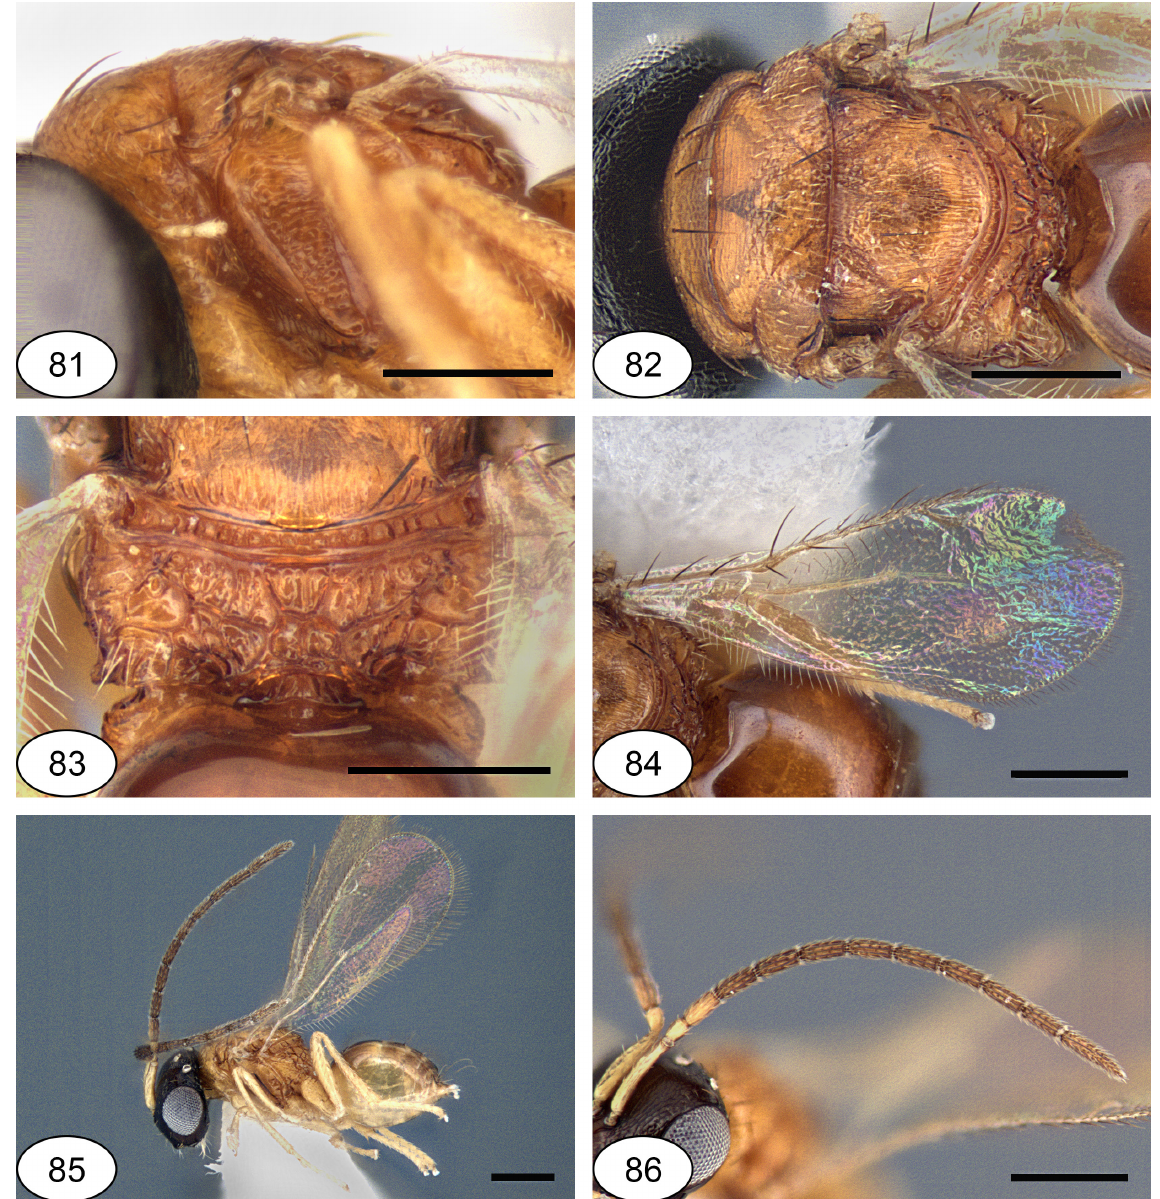
Figs 81–86. Netomocera gloriosa sp. nov. 81 . Holotype, ♀, mesosoma, lateral view. 82 . Holotype, ♀, mesosoma, dorsal view. 83 . Holotype, ♀, propodeum, dorsal view. 84 . Holotype, ♀, fore wing. 85 . Allotype, ♂, habitus, lateral view. 86 . Allotype, ♂, antenna. Scale bars: 0.2